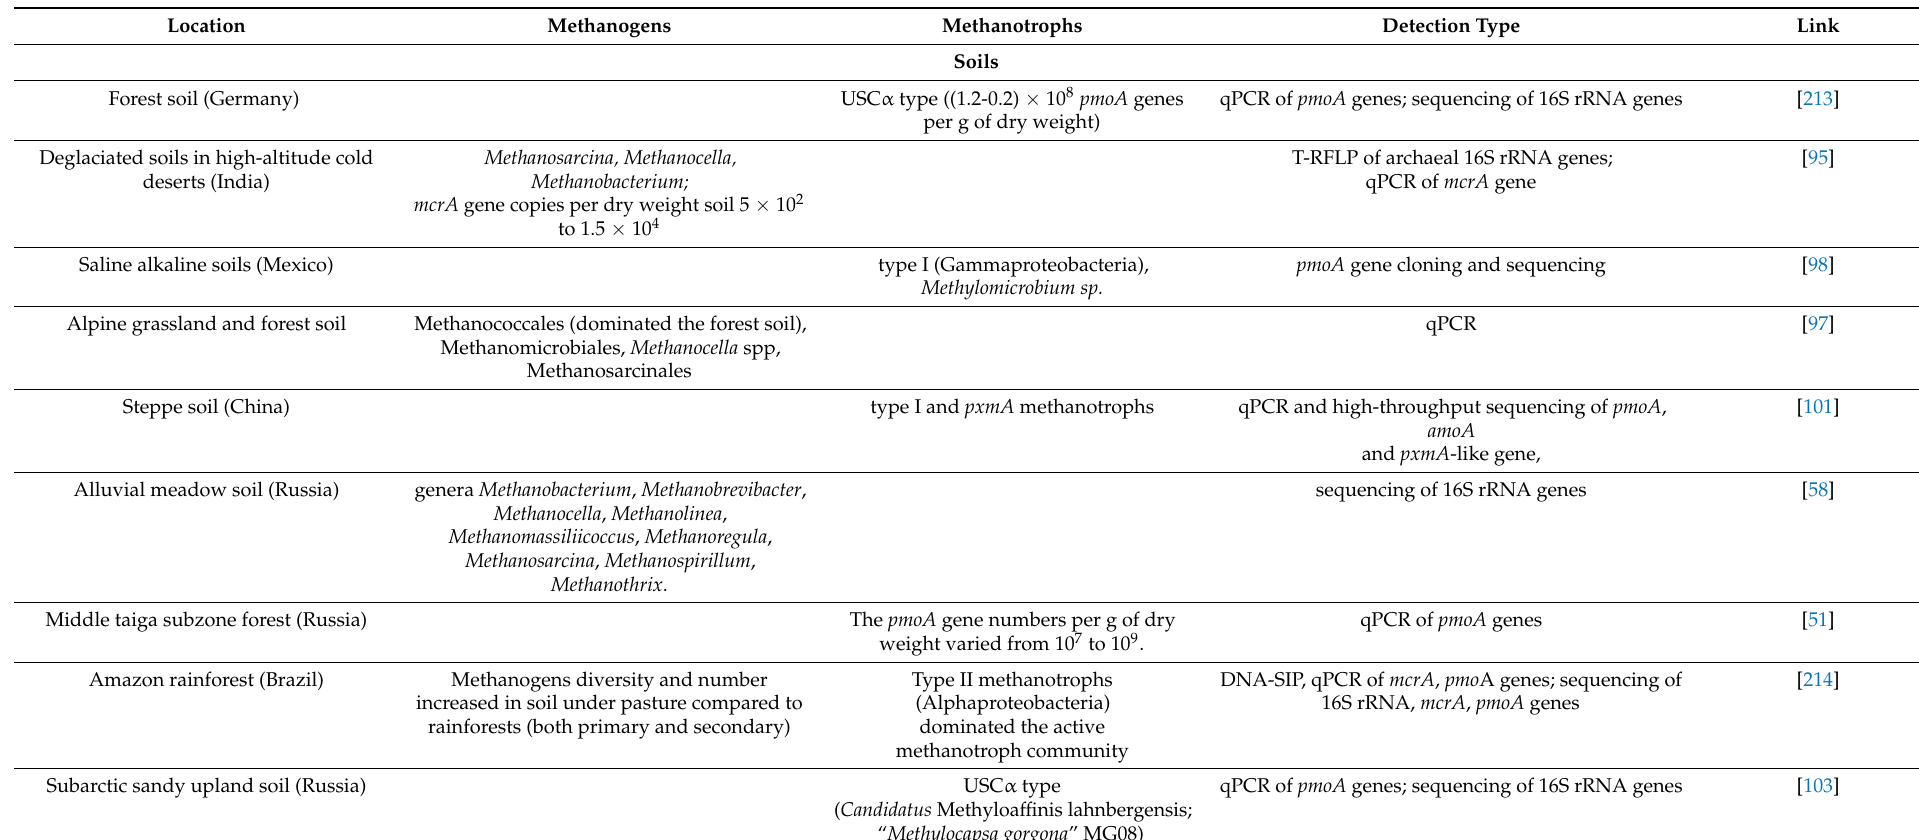
Table 2. Examples of methanogens and methanotrophs found in different